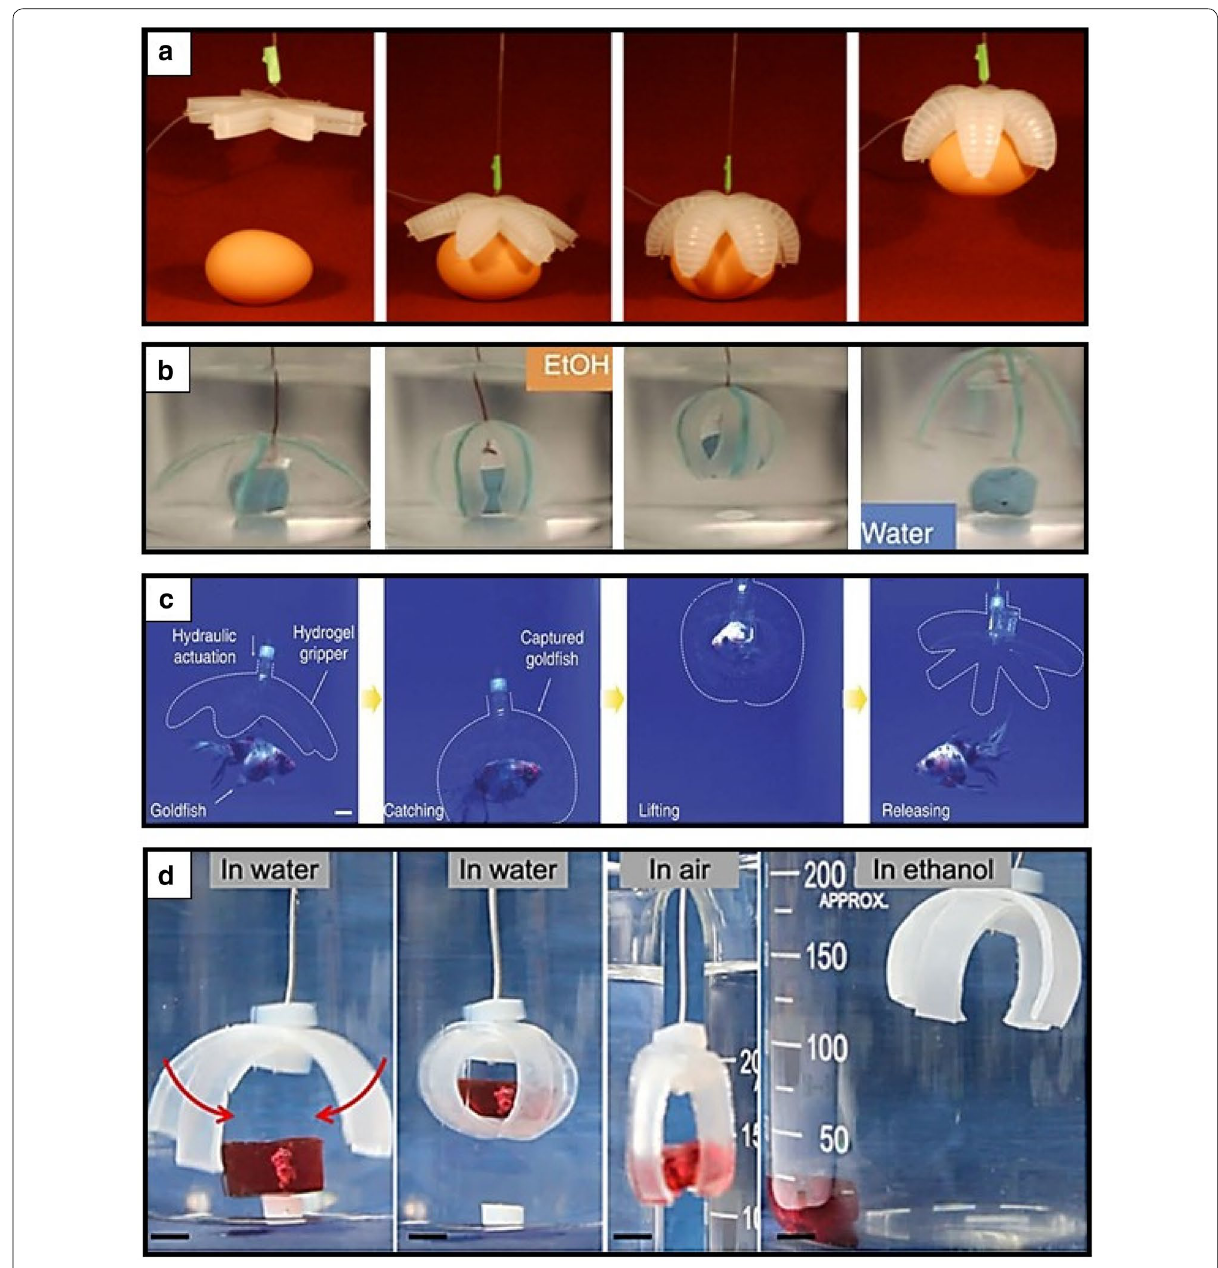
Fig. 5 Tethered soft grippers as smart actuators or manipulators. a Pneumatically driven tethered soft gripping robot that provides a range of complex motions by curling upwards or downwards controlled by expansion and contraction in elastomeric structures (reproduced with permission [15]. Copyright 2011, Wiley–VCH). b X-shaped ion-printed tethered electrical assistant soft gripper that presents rapid grasp a target in ethanol and releases it in water reversibly (reproduced with permission [99]. Copyright 2013, Springer Nature). c Optically and sonically camouflageable hydraulic hydrogel gripping robot that holds and releases a live goldfish noninvasively (reproduced with permission [100].